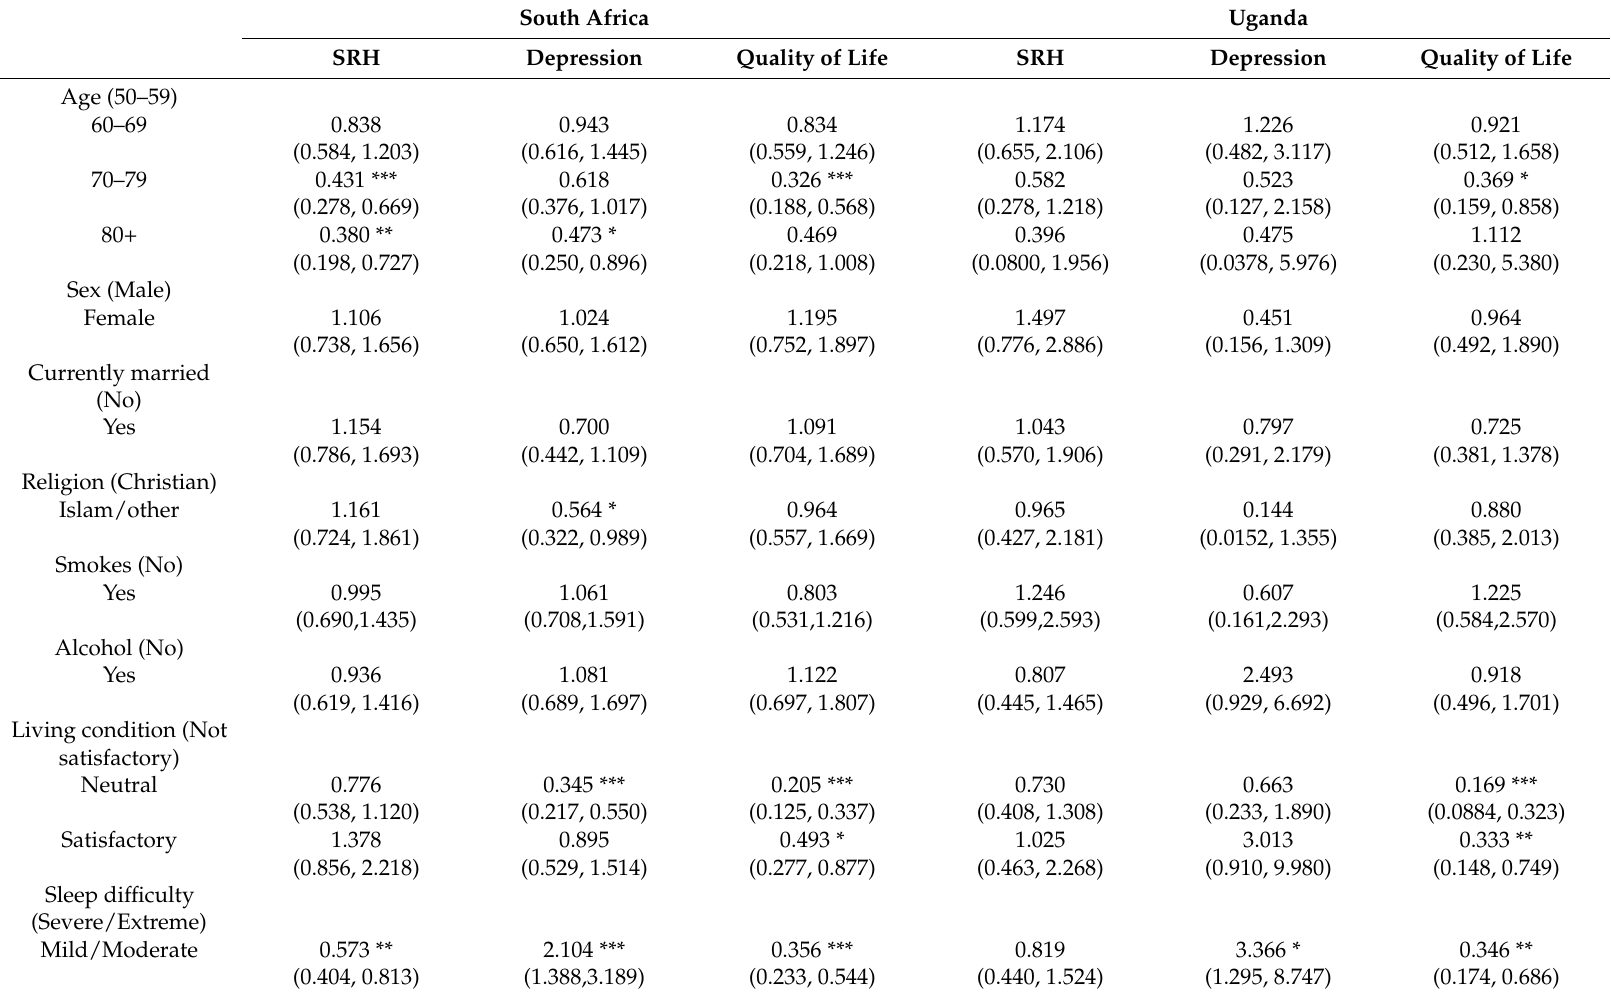
Table 5. Association between CMP with SRH, depression and QoL in South Africa and Uganda. South Africa